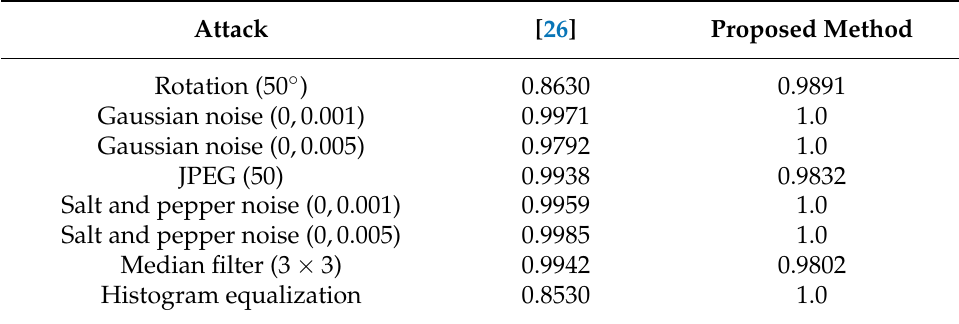
Table 13. Robustness comparison measured in terms of NC for Lena image.